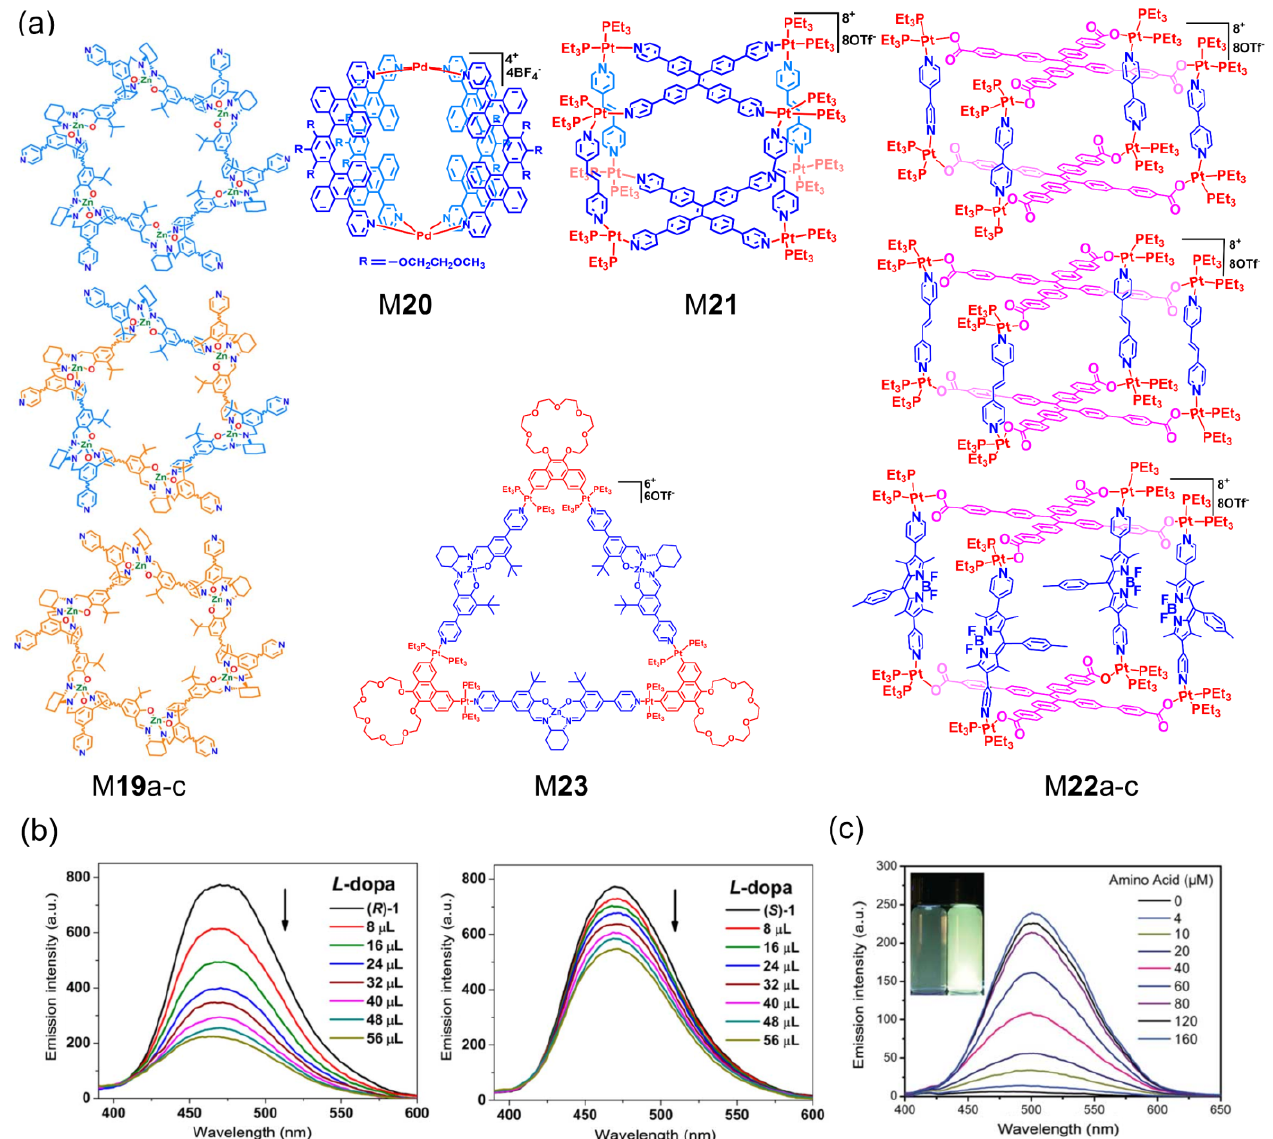
Figure 4. Biological recognition and sensing of metallacycles and metallacages. ( a ) The structures of M 19 − M 23 . ( b ) Fluorescence emission spectra of (R)- and (S)-M 19 a (2.0 × 10 -6 M in THF) upon titration with L-dopa. ( c ) Fluorescence spectra of M 22 with increasing amounts of thiol-containing amino acids. Adapted with permission from refs. [31,34,76–78]. Copyright 2017 and 2021 American Chemical Society; 2020 Royal Society of Chemistry; 2017 American Association for the Advancement of